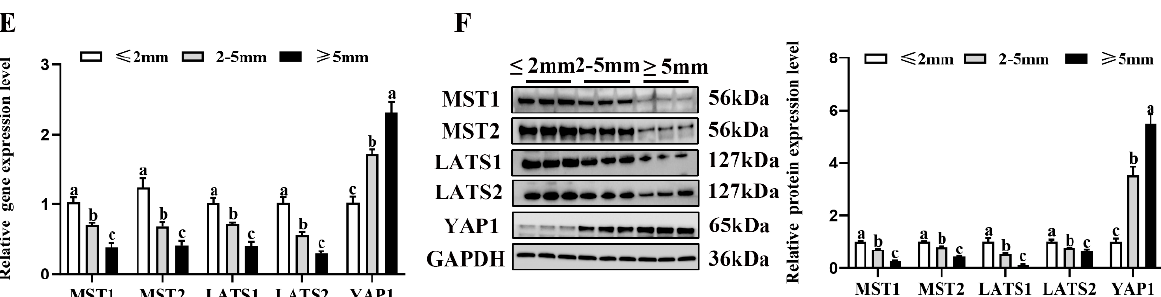
Figure 6. Localization and expression of the Hippo pathway core components in goat granulosa cells. ( A ) The mRNA expression of the Hippo pathway core components (MST1, MST2, LATS1, LATS2, and YAP1) in three-month-old and nine-month-old goat ovaries was detected by qPCR. ( B ) The mRNA expression of the Hippo pathway core components in three-month-old and nine-month-old goat ovaries was detected by Western blot. ( C ) Localization of the Hippo pathway core components proteins in goat ovaries. Positive signals appeared brown and counterstaining background appeared blue. ( a – a4 ): stained with MST1 polyclonal antibody; ( b – b4 ): stained with MST2 polyclonal antibody; ( c – c4 ): stained with LAST1 polyclonal antibody; ( d – d4 ): stained with LATS2 polyclonal antibody; ( e – e4 ): stained with YAP1 polyclonal antibody; ( f – f4 ): negative control (no significant immunoreactivity was observed with normal fetal bovine serum instead of the primary antibody); EN: oocyte nest; PM: primordial follicle; PR: primary follicle; SC: secondary follicle; TR: tertiary follicle; scale bar 50 μ m. ( D ) Localization of the Hippo pathway core components in cultured goat GCs. Blue color: DAPI-stained nuclei; green color: immunofluorescence representing the reaction of antibodies with antigens; ( E ) The mRNA expression of the Hippo pathway core components in different diameters of follicles was detected by qPCR. ( F ) The protein expression of the Hippo pathway core components in different diameters of follicles was detected by Western blot; the data are presented as mean ± S.E.M. value from at least three individuals. Different letters indicate significant differences in the expressions between the groups ( p < 0.05).